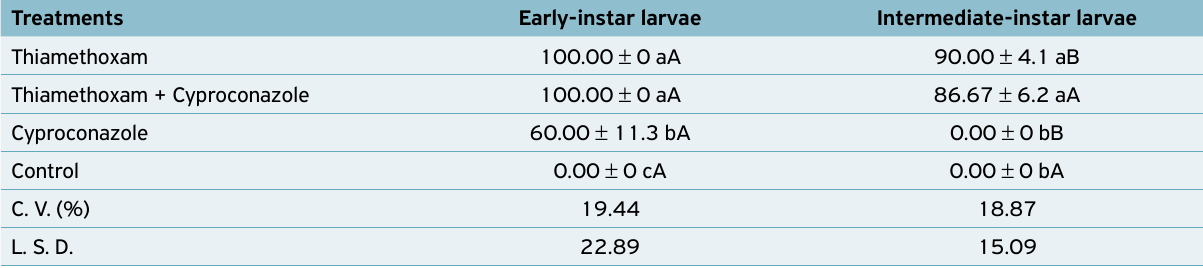
Table 2. Percent mortality (mean ± SE) of early-instar and intermediate-instar larvae of Rhynchophorus palmarum , after 48 hours on an artificial diet containing thiamethoxam and